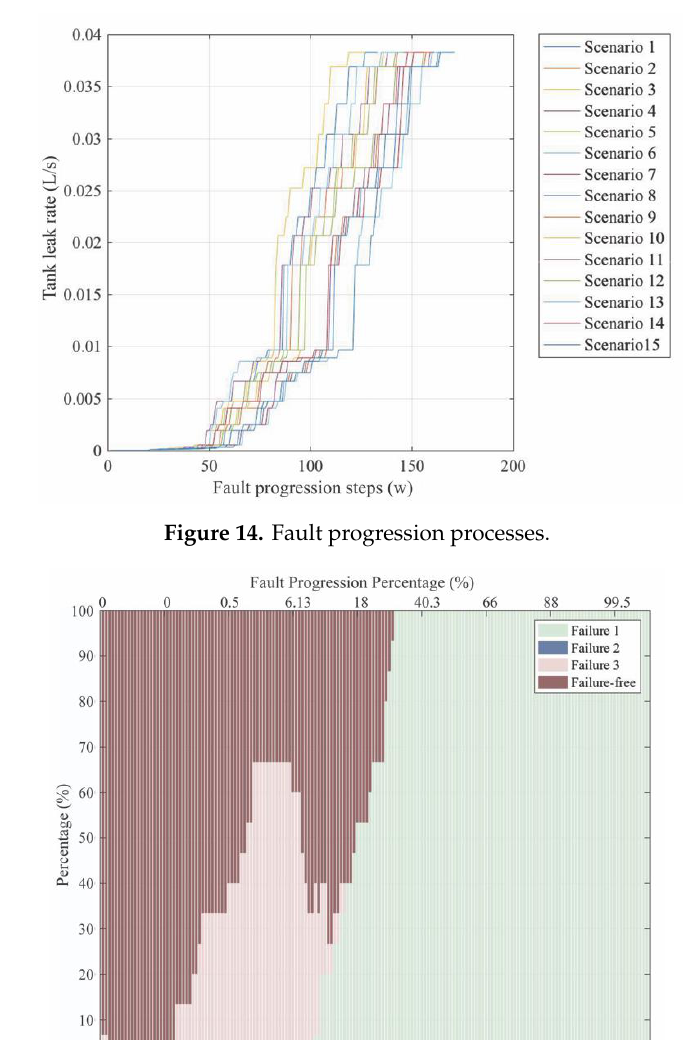
Figure 14. Fault progression processes.